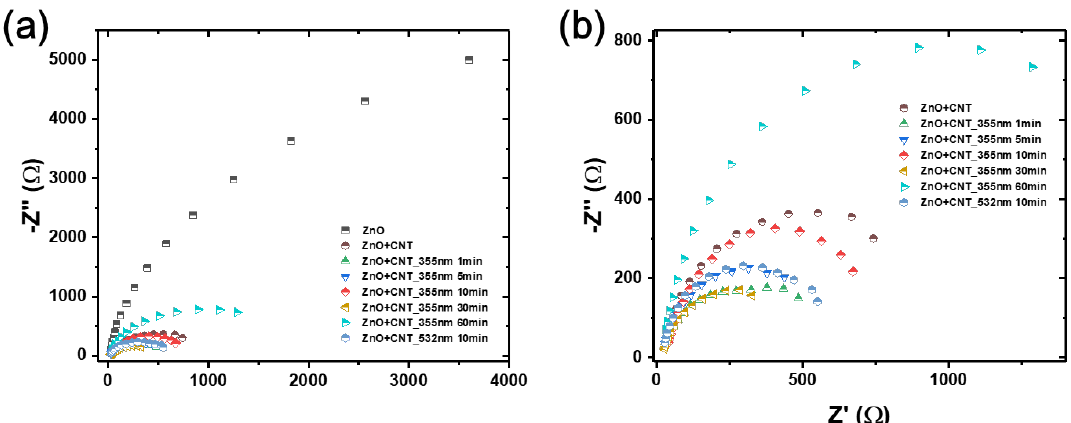
Figure 10. Electrochemical impedance spectroscopy (EIS) spectra of ZnO NS and ZnO NS-CNT hybrids measured ( a ) in the dark and ( b ) under light in a 0.5 M Na 2 SO 4 electrolyte.